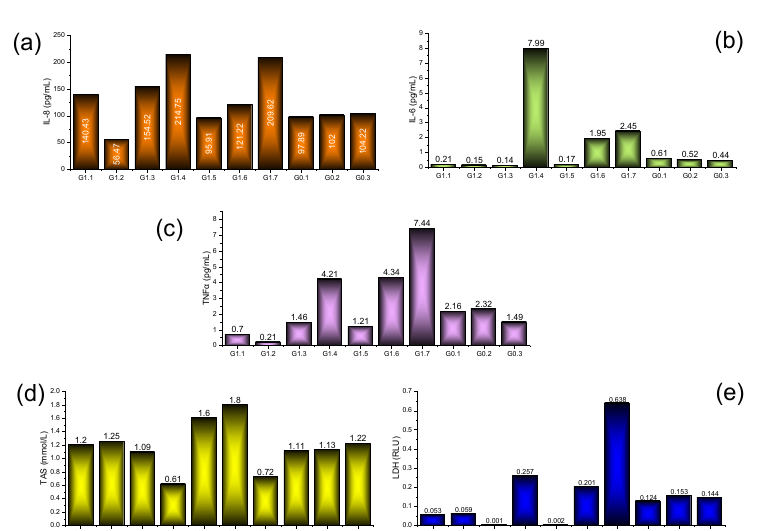
Figure 3. Proinflammatory cytokines IL-6 ( a ), IL-8 ( b ) and TNF- α ( c ), total antioxidant status (TAS) ( d ) and lactate dehydrogenase (LDH) values ( e ) for the ten patients from Group 1 (G1.1–G1.7) and Group 0 (G0.1–G0.3).